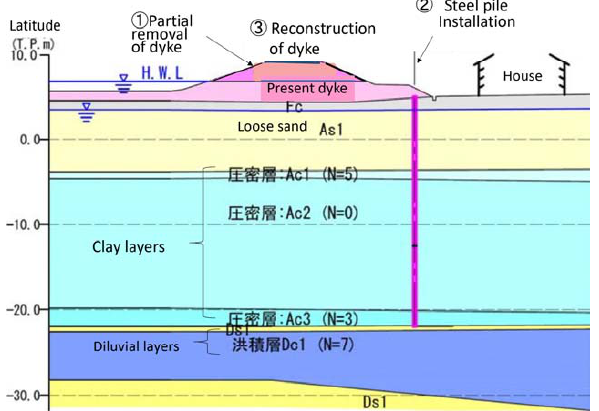
Figure 7. Remediation for reducing post-earthquake settlement of soft clay